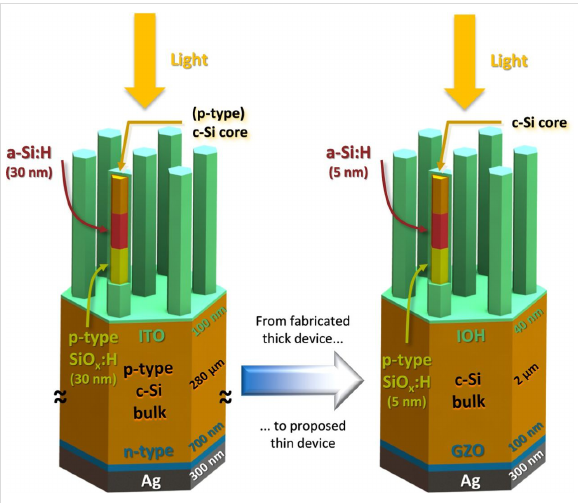
Figure 3: 3D rendering of the real device (left) and of the simulation model (right). The differences are: thinner absorber (device: 280 μ m, model: 2 μ m), thinner and more transparent supporting layers (p-type SiO x :H + a-Si:H + TCO) at the front (device: 30 nm + 30 nm + 100 nm, model: 5 nm + 5 nm + 40 nm), introduction of a TCO between silicon and metal at the back, in place of the implanted n-type doped silicon layer. The core of one nanowire (c-Si, orange) is presented in both figures, to show the layers that are coating it